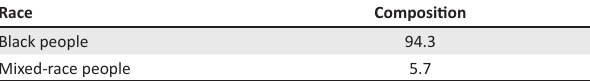
TABLE 2 : Racial representation of participants. Race Composition